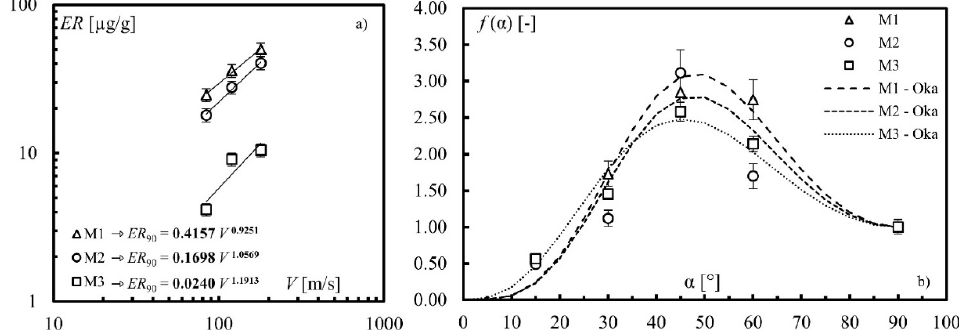
Figure 3. Results of the experimental test: ( a ) erosion rate at normal impingement angle, and ( b ) erosion rate over the angle (experimental values and Oka’s model interpolation).